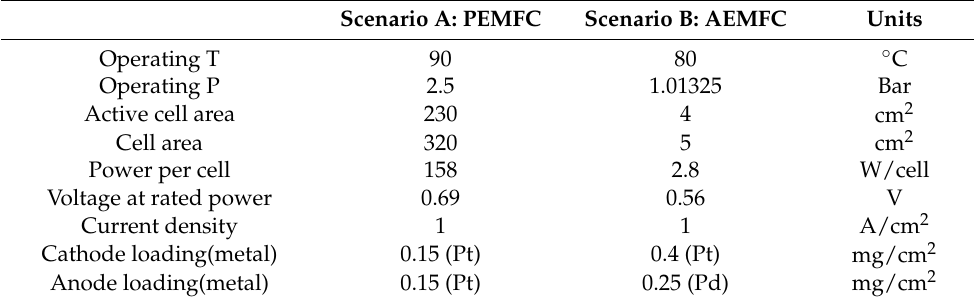
Table 2. Operating conditions and outputs of the tested fuel cell. For Scenario A the complete stack has been tested, for scenario B only a single